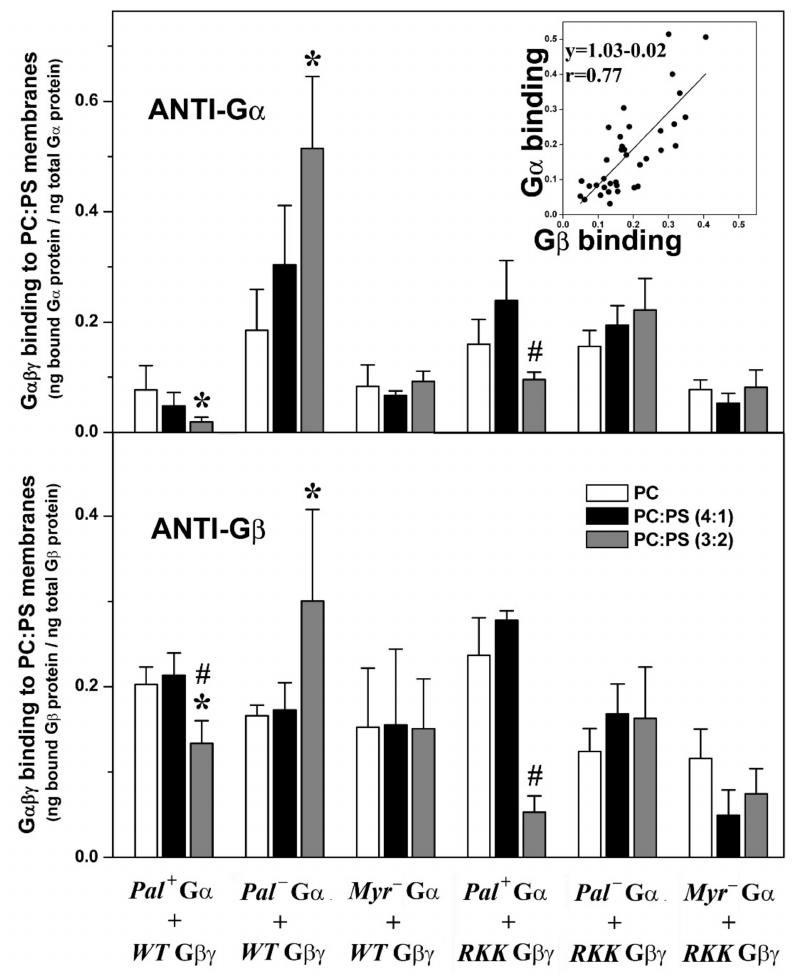
Figure 5. Effects of PS and the G α i 1 and G γ 2 structures on G αβγ –membrane interactions. In the upper panel, the bars show mean ± S.E.M. values of G α i 1 β 1 γ 2 heterotrimer binding to PC and